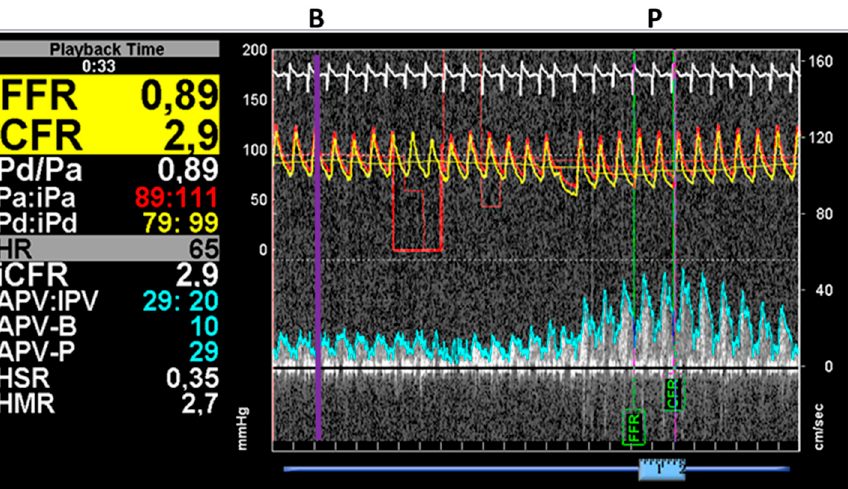
Figure 2. Results of simultaneous pressure and flow measurements by the ComboWire. In this case, the average proximal (aortic) and distal pressures were detected to be 95 mmHg and 88 mmHg, respectively. At maximal hyperemia (P), the average peak velocity (APV-P) increased to 29 cm/s from the basal (B) velocity of 10 cm/s (APV-B) parallel with the increase in the pressure drop (the proximal and distal pressures were 89 mmHg and 79 mmHg, respectively). The measured FFR was 0.89, while the CFR was 2.9 (Case